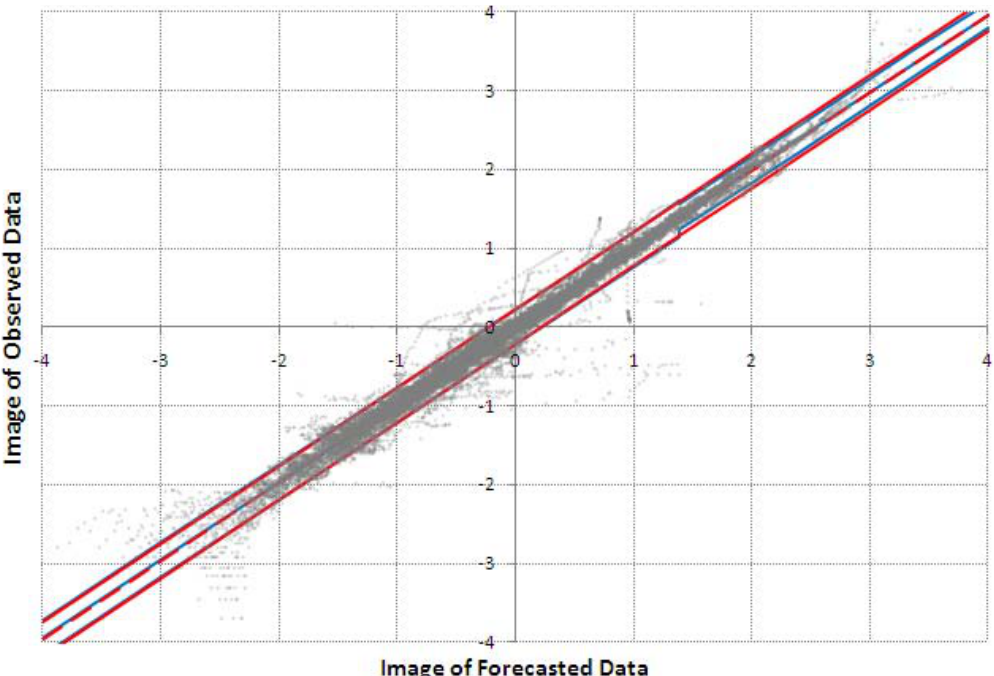
Fig. 7. Representation of the Normal Space obtained applying the MCP to the Po river. The full red lines represent the 5% and 95% quantiles and the dashed red line the 50% quantile obtained without using the TNDs methodology. The blue lines represent the quantiles obtained using the TNDs methodology.